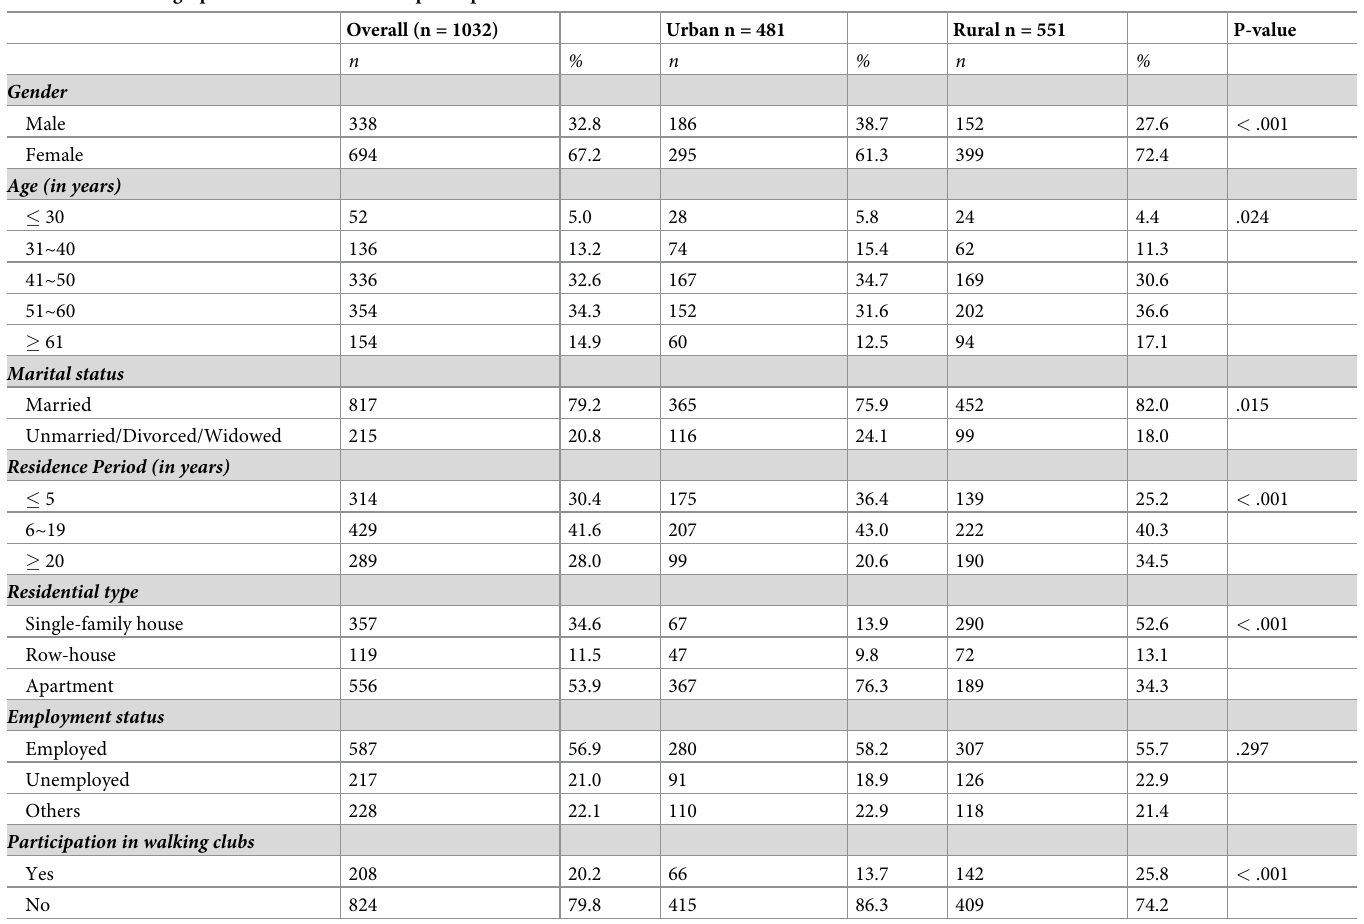
Table 1. Sociodemographic characteristics of the